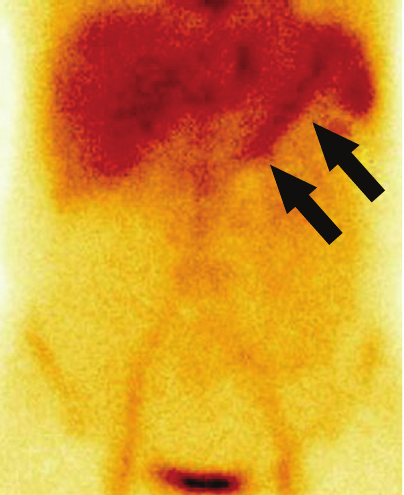
Figure 1: 18-year-old woman with enterorrhagia. 99 m Tc-RBC scin- tigraphy, anterior view, 15 minutes after intravenous injection of the radiotracer.Bleedingfromtheileosigmoidanastomosissixdaysafter hemicolectomy for Crohn’s disease ( arrow head ).